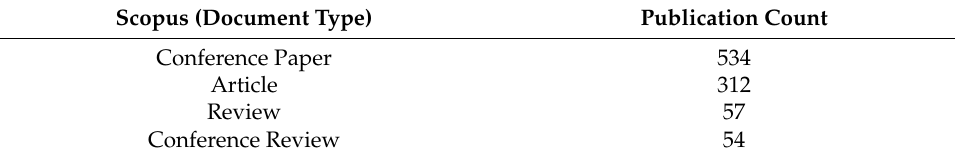
Figure 8. Analysis of documents by type. (WoS core collection). Table 6. Publication count by type (WoS core collection). Table 5. Publication count by document type (Scopus database).